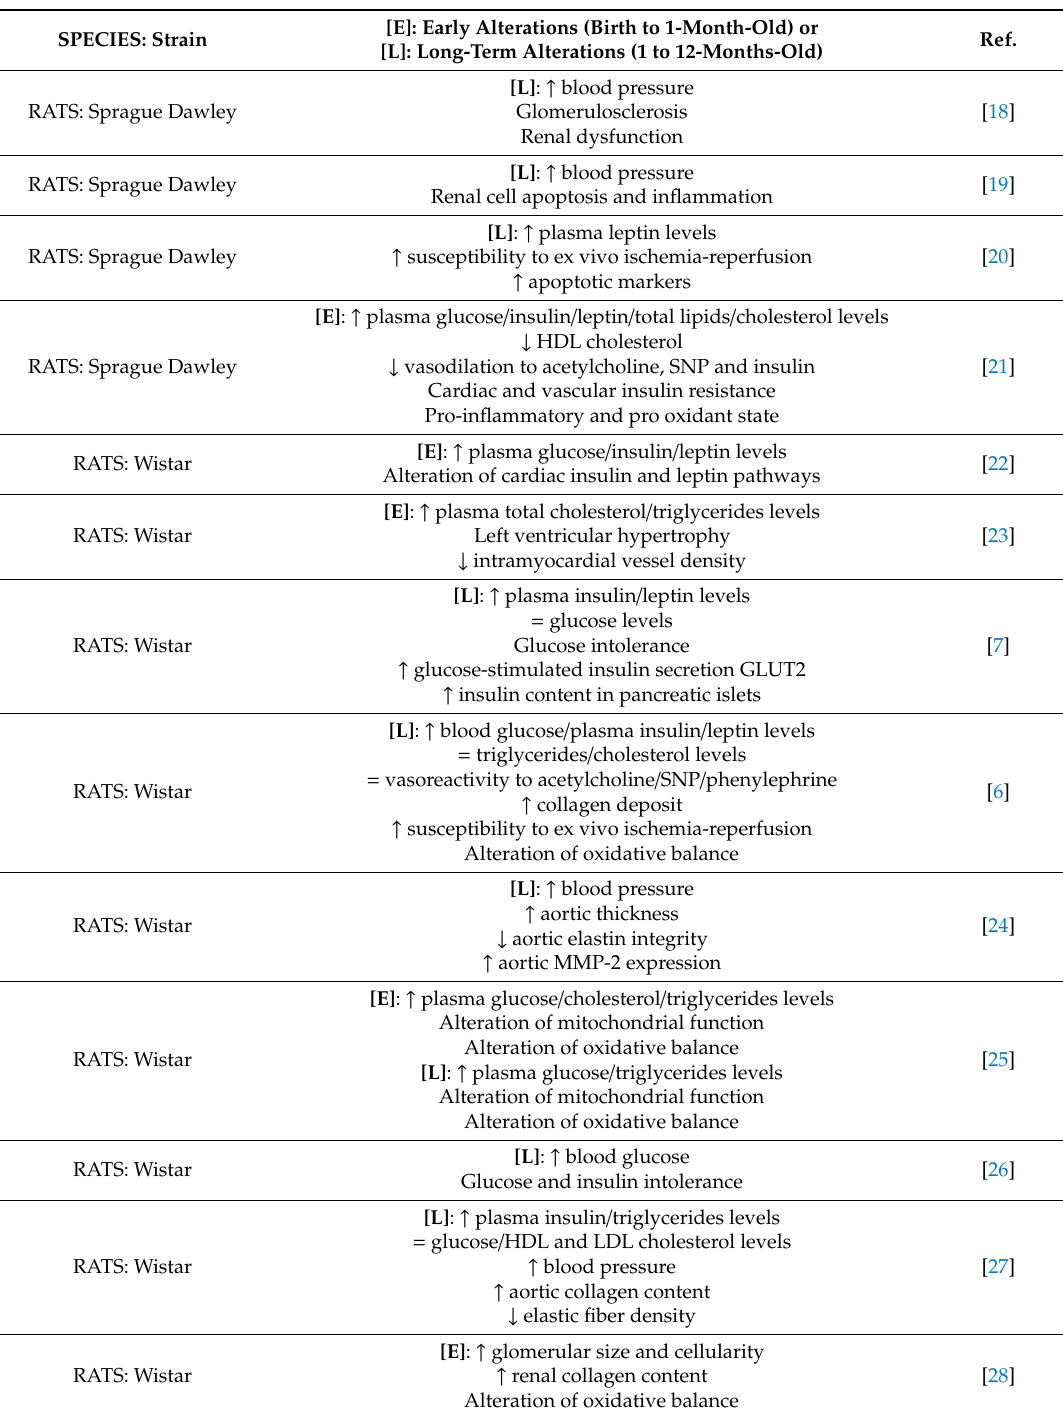
Table 1. Summary of early ( [E] : birth to 1-month-old) and long-term ( [L] : 1 to 12-months-old) cardiovascular and metabolic alterations induced by the postnatal overfeeding of male rodents. ↑ : significantly increased compared to control; ↓ : significantly decreased compared to control; = : similar to